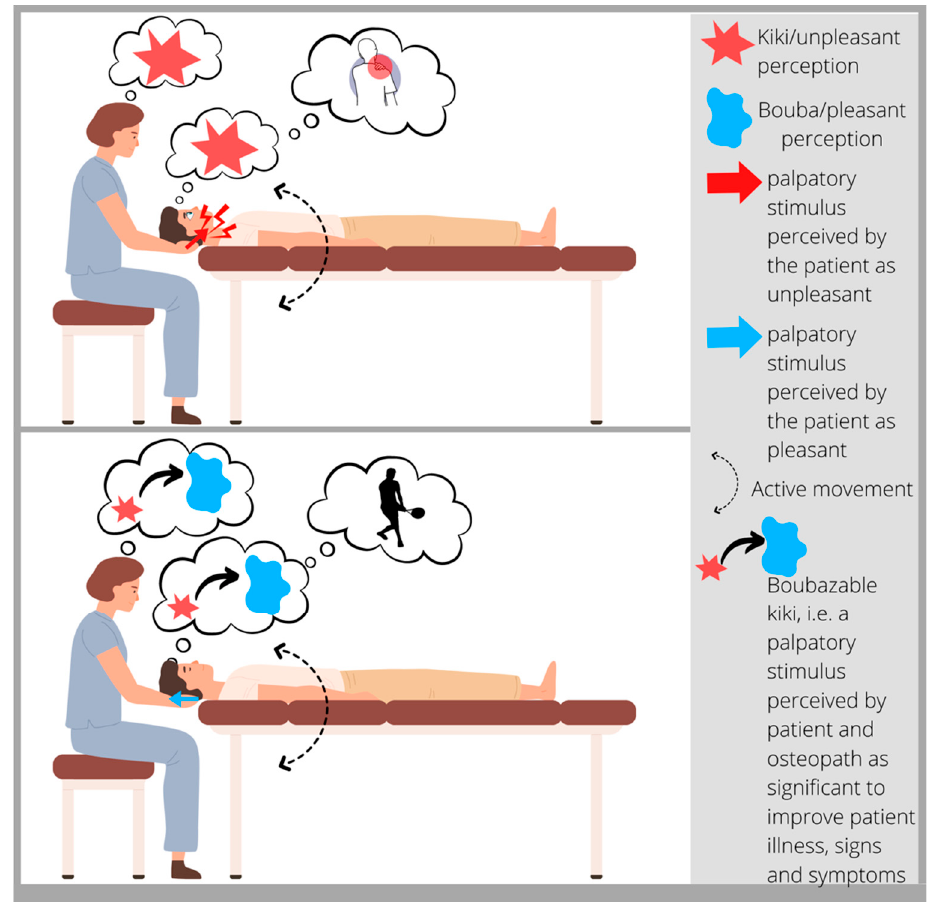
Figure 3. SFCT in the Neuroaesthetic Enactive perspective. The SFCT aims to produce a pleasant surprise (in the figure: patient perception of improved pain and motion of the right upper limb) and a significant prediction error that will defy prior assumptions and update the brain’s generative model (in the figure: I can go back playing tennis) by a nonverbal exchange between the patient and the osteopath, supported by narrative interactions.